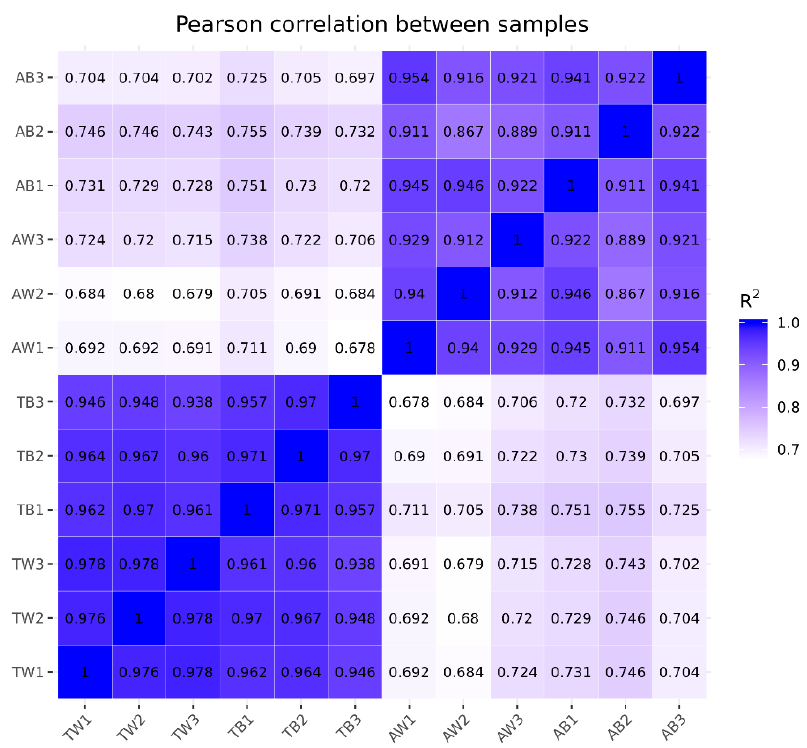
Figure 1. Comparison of the distribution of gene expression levels in different samples. The abscissa is the sample name, and the ordinate is log2 (FPKM + 1).